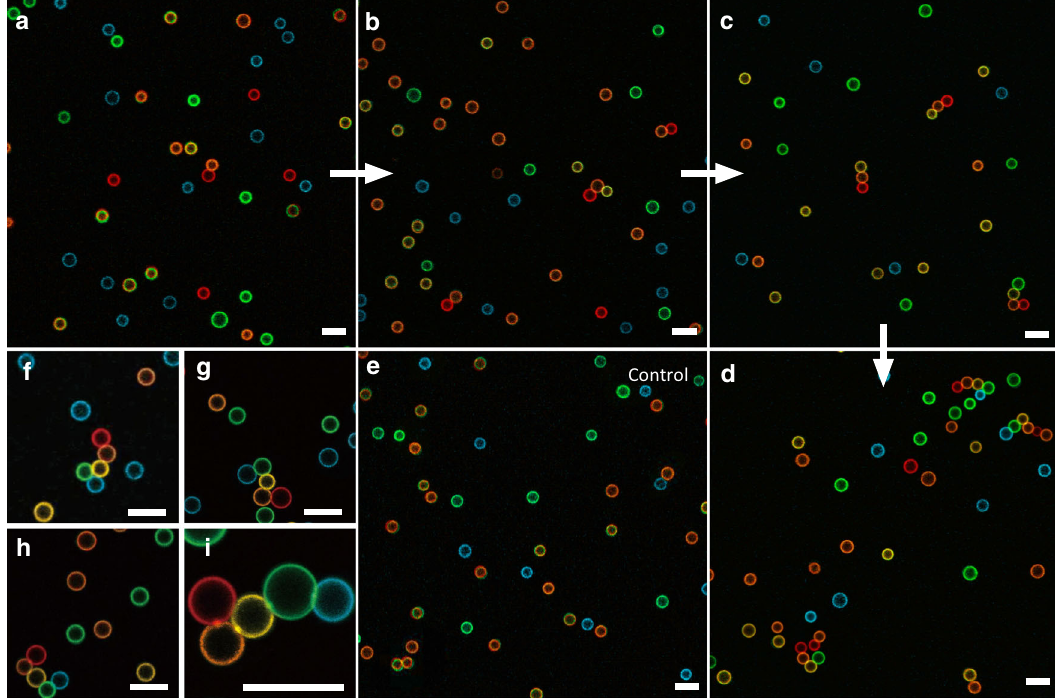
Fig. 3 Representative confocal images of sequentially self-assembled structures. In the experiment, droplets A, B, C, D, and E were false colored red, orange, yellow, green, and blue. a – d Images taken after 10 h, 26 h, 74 h, and 101 h of incubation, respectively, showing the growth of triggered sequential self-assembly (SSA). e An image taken from the control experiment (no initiators) after 101-h incubation. f – h A gallery of various self-assembled pentamers. i A zoom-in view of a pentamer showing the patch formed at each droplets binding. All scale bars are 10 μ